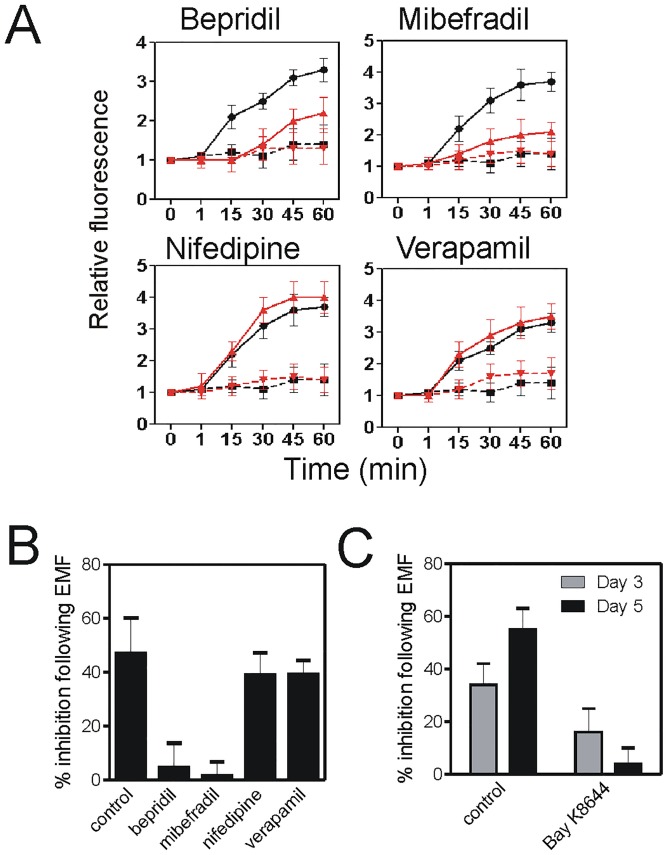
Thomas-EMF-dependent Ca2+ uptake and proliferation are mediated by T-type Ca2+ channels.A. B16-BL6 cells were treated with media (black lines) or inhibitors of L- or T-type Ca2+ channels for 30 min (red lines) and labelled with FLUO-4(AM). The cells were exposed to Thomas-EMF (solid lines) or sham field (dashed lines), and images taken at 1, 15, 30, 45, and 60 min. The relative fluorescence was determined using MetaMax software and the average ± SD fold increase for 3 independent experiments was plotted versus exposure time. B. The percent inhibition of B16-BL6 cells treated with Thomas-EMF for 5 days relative to sham-treated cells is shown in cells also treated with media (control), inhibitors of T-type Ca2+ channels (bepridil or mibefradil), or inhibitors of L-type channels (nifedipine or verapamil). The number of cells was determined for each condition and the percent inhibition (mean ±SD for 3 independent experiments) was determined as the difference between Thomas-EMF and sham-treated conditions relative to the control where * indicates p<0.05 (Students t-test). C. The percent inhibition of B16-BL6 cells treated with Bay K8644 or Thomas-EMF for 3 and 5 days relative to sham-treated cells is shown. The percent inhibition in cell proliferation (mean ± SD for 3 independent experiments) is shown.